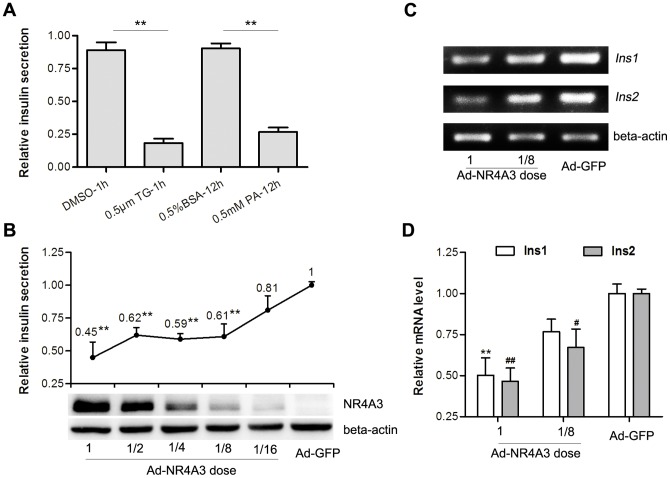
Insulin secretion and mRNA assay in MIN6 cells after infection with equivalent titer of adenovirus.(A, B) Analysis of insulin secretion after glucose stimulation assayed by radioimmunoassay (RIA). (A) MIN6 cells were treated with 0.5 µM thapsigargin (TG) or DMSO (vehicle control) for 1 h, 0.5 mM palmitate (PA) or 0.5% BSA (vehicle control) for 12 h, and the supernatants were assayed for insulin protein level (n = 3). (B) MIN6 cells were infected with a series of double dilutions of Ad-NR4A3 adenovirus (adenovirus encoding NR4A3). Additional Ad-GFP (control adenovirus expressing GFP only) was used for complementary infection in order to ensure each infection had an equal virus titer. Post-infection, levels of secreted insulin were assayed by RIA (n = 4). Western blotting showed NR4A3 protein expression gradually decreasing, and insulin secretion level increasing accordingly. (C) mRNA levels of two insulin genes (Ins1 and Ins2) were determined with reverse transcription PCR in MIN6 cells infected with Ad-NR4A3/Ad-GFP. (D) Semi-quantitative analyses of Ins1 and Ins2 mRNA levels in different adenovirus-infected MIN6 cells (normalized to beta actin) (n = 6). Data are shown as mean ± S.E. # p<0.05; **, ## p<0.01 vs. the control group or Ad-GFP infection only.